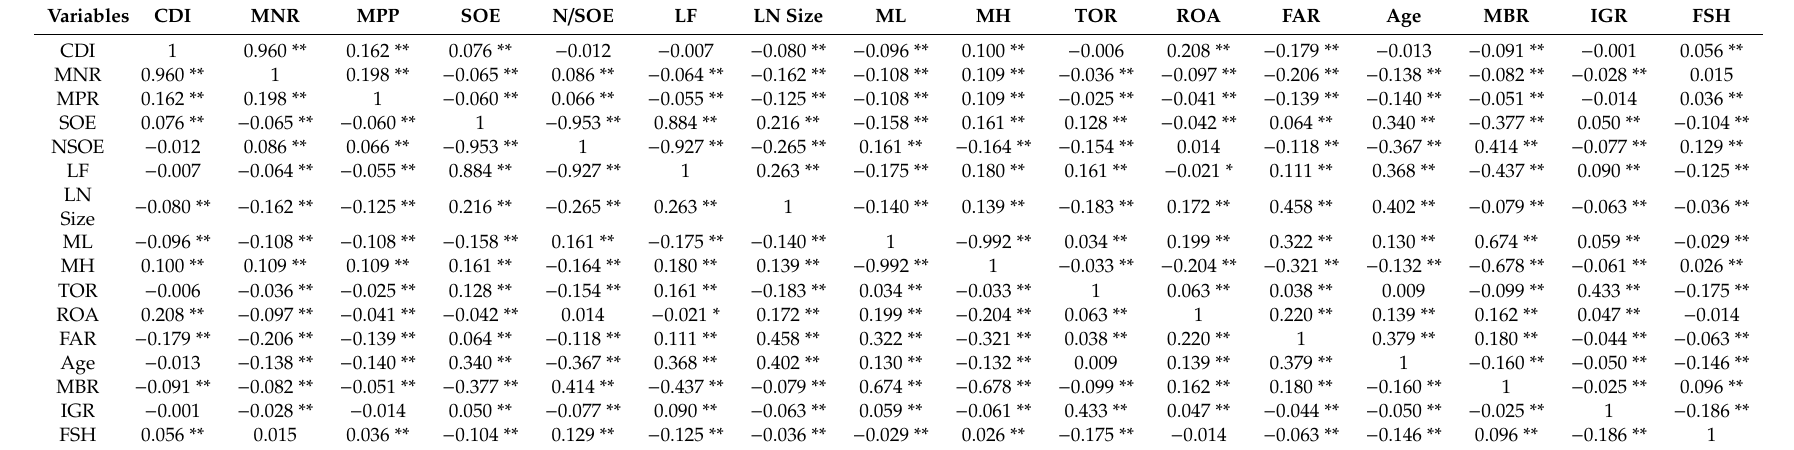
Table 3. Pearson Correlation Coe ffi